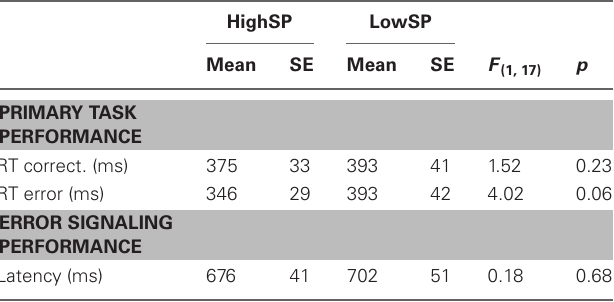
Table 2 | Behavioral performance in matched